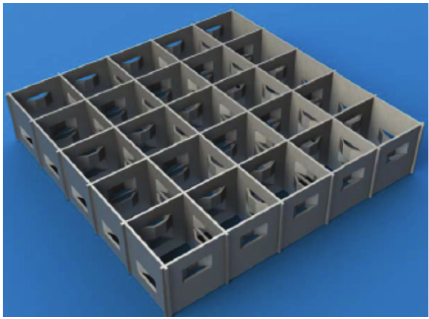
Figure 7: View of simple spacer grid.